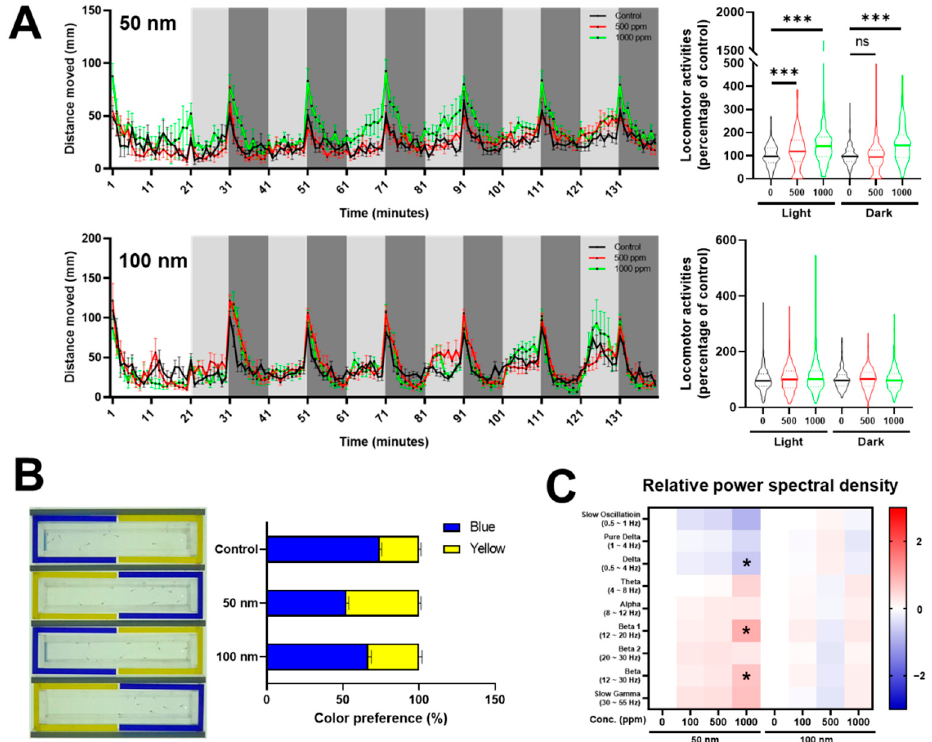
Figure 2. Behavioral and electroencephalogram (EEG) analysis of polystyrene nanoparticles (PS- NPs)-exposed zebrafish larvae. ( A ) Light and dark transition test. Experimental concentration of both PS-NPs were 1000 ppm. ( B ) Color preference test in blue–yellow chamber. ( C ) Heatmap of relative power spectral density through EEG analysis. The normalized Z-scores were calculated by the mean of the population and standard deviation of the population. Data sets were expressed as the means ± standard error of the mean and statistical significance was set at 0.05, 0.01, and 0.001 (* p ≤ 0.05, *** p ≤ 0.001, ns—not statistically significant).